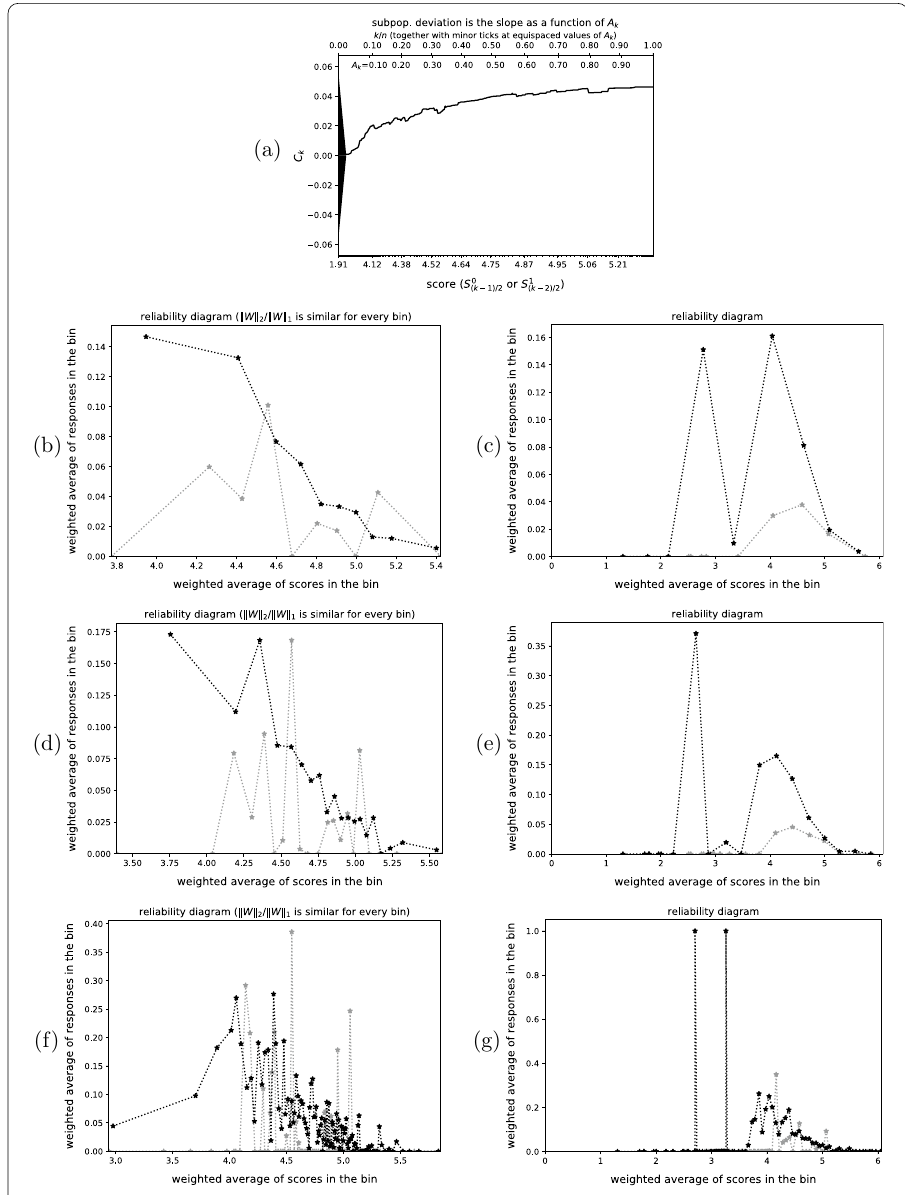
Fig. 15 Riverside County vs. Butte County; n = 1478; Kuiper’s statistic is 0.04624 /σ = 1.650 , Kolmogorov’s and Smirnov’s is 0.04624 /σ = 1.650 ; resolving both the phenomena corresponding to the fairly flat part and the phenomena corresponding to the very steep part of the cumulative graph ( a ) for the lowest scores requires at least 100 bins in the reliability diagrams ( f and g ), but then the rest of the diagrams is very noisy. The statistics of Kuiper and of Kolmogorov and Smirnov do not report much statistically significant deviation between the